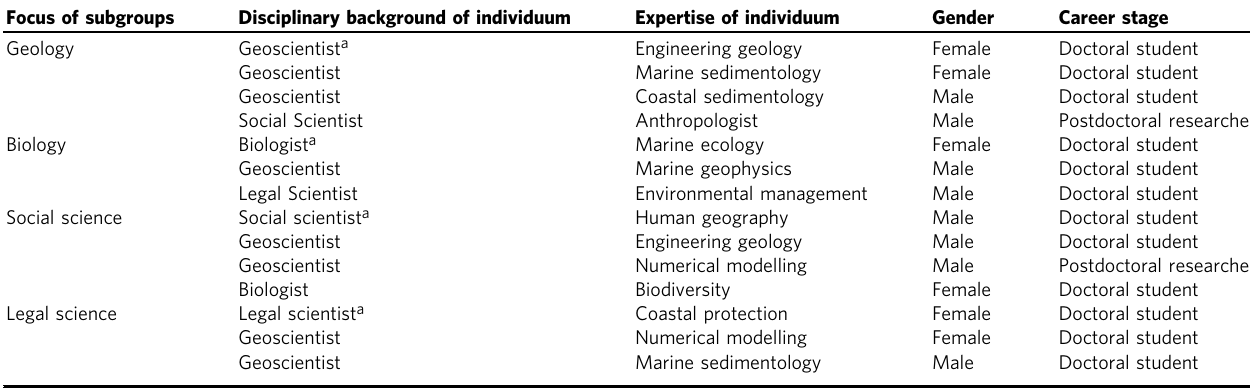
Table 1 Composition of the group project InterWind.